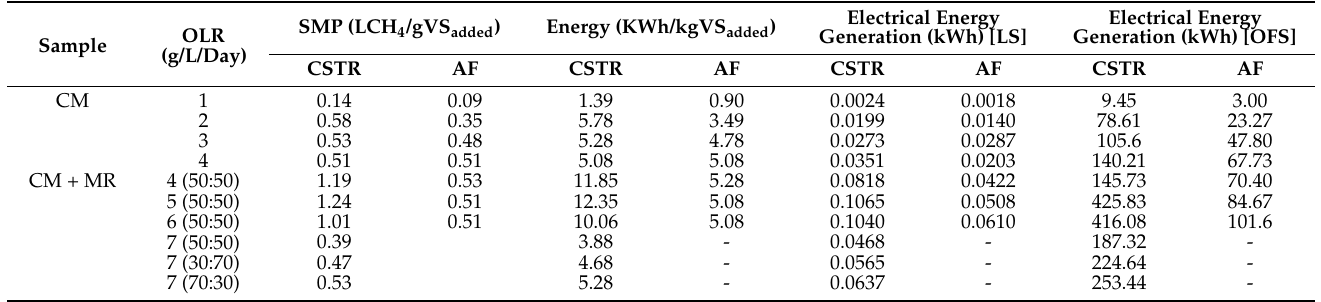
Table 10. Summary of electrical energy yield for samples of CM and CM + MR in different